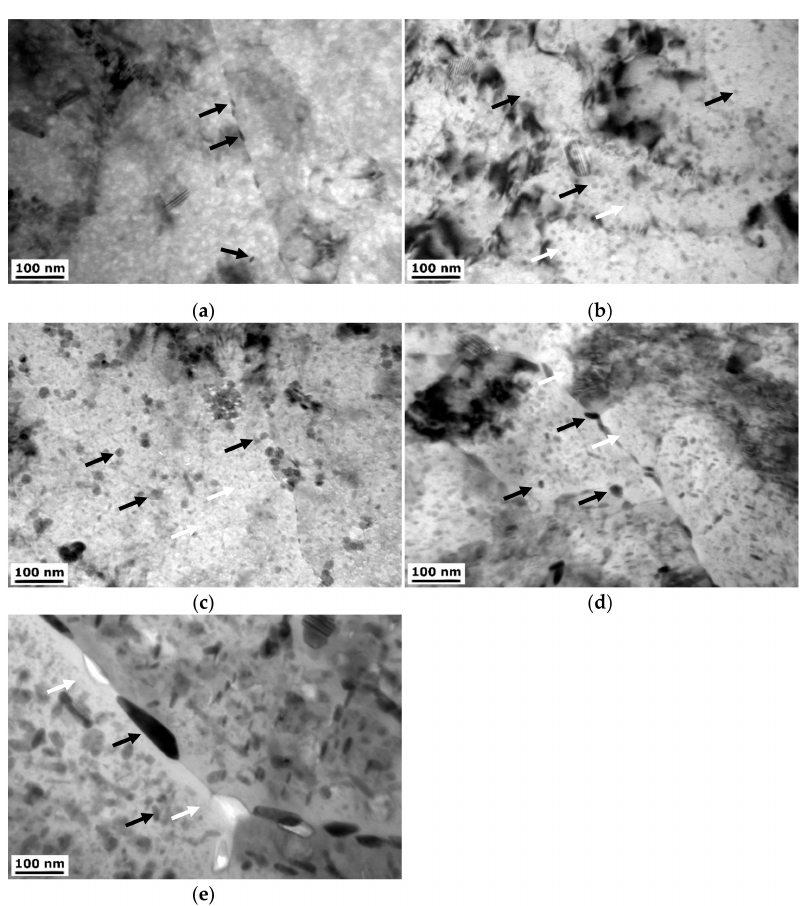
Figure 8. TEM micrographs of the: ( a ) HE10, ( b ) HE10 HT1, ( c ) HE10 HT2, ( d ) HE10 RRA1, and ( e ) HE10 RRA2 samples, black arrows indicate η precipitates, white arrows— η (cid:48) precipitates.